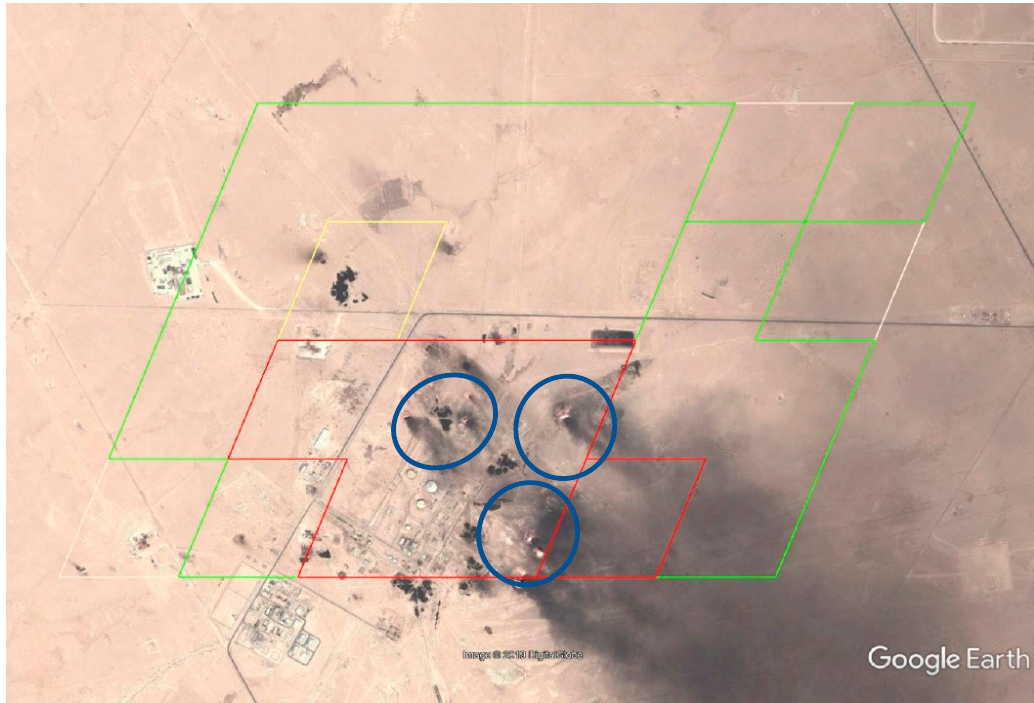
Figure 2. Illustrative proof of concept results over gas flares in Iraq (centered at N 30.216575, E 47.39269). Background Google Earth ™ image was acquired on 31 August 2010 while the overlaid pixels are all 500 m pixels within the six 1 km detection footprint detected on 1 February 2019, DOY 032. Colored boundary lines outline the area encompassed by nine 1 km active detection pixels (Table 1, Cluster ID 2). Colored outlines mark the high (red), moderate (yellow) and low (green) and poor (white) probabilities of subpixels containing active fire(s). Gas flares (within blue ovals) are evidently closest to the contiguous high probability locations and further away from the poor probability locations. Out of the six contiguous high probability pixels three do not have any obvious flare stack.